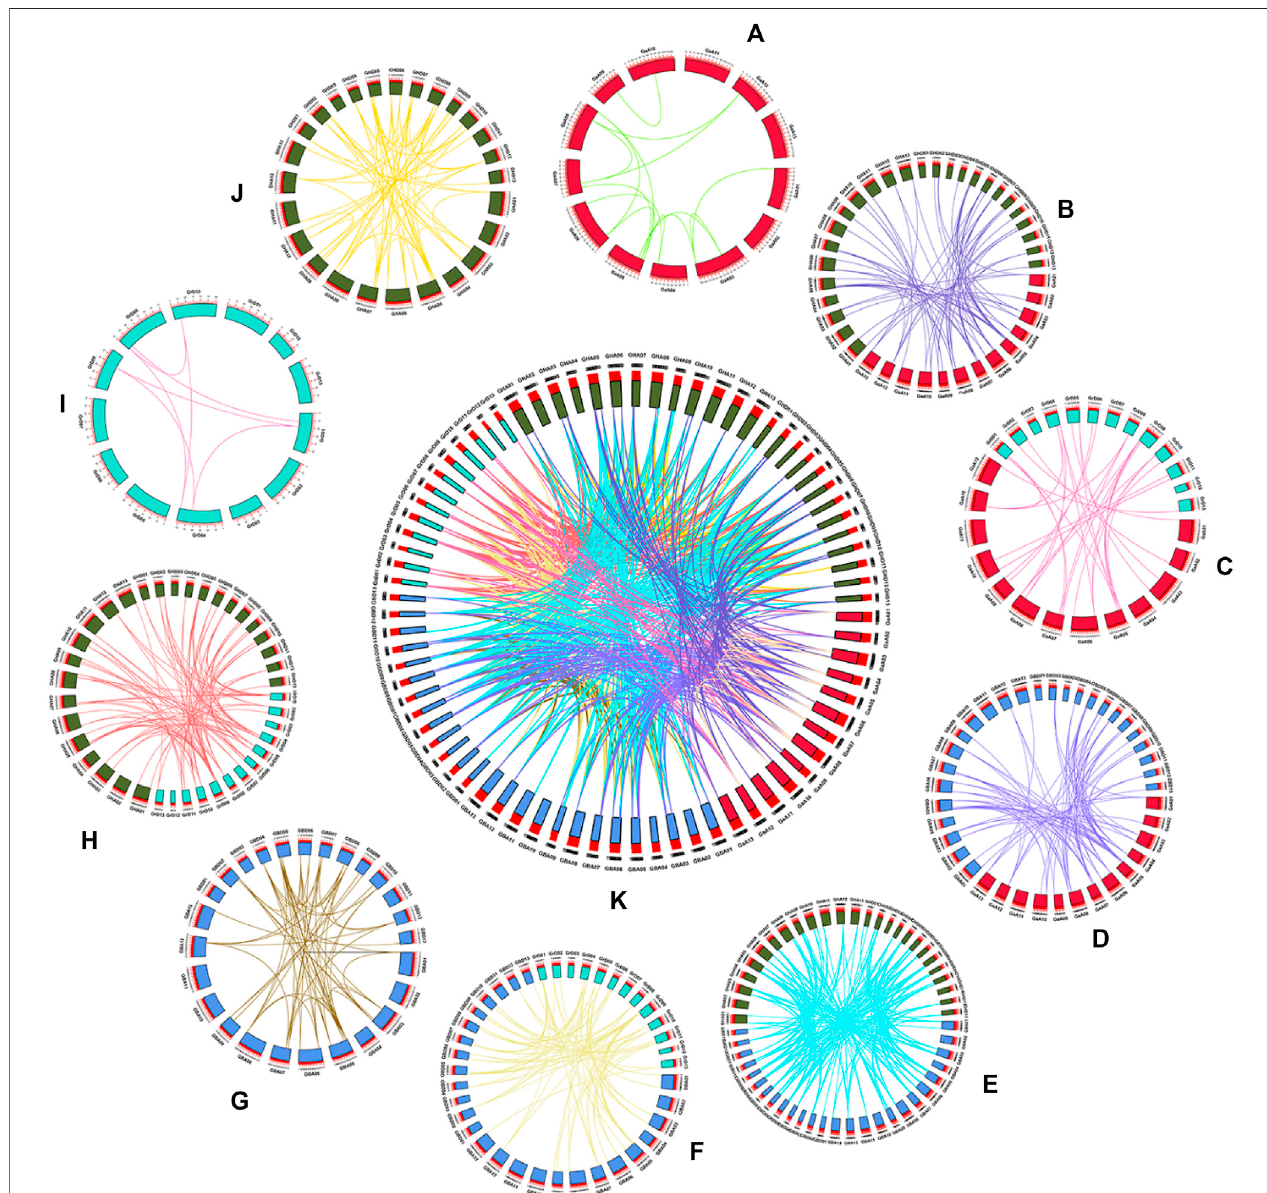
FIGURE 6 | The collinearity of KCS genes within and among the four cotton species genomes ( Gossypium hirsutum , Gossypium barbadense , Gossypium arboreum and Gossypiumraimondii ).Chromosomallinesrepresentedbyvariouscolorsindicatethesyntenicregionsaroundthe KCS genes. (A) Ga-Ga, (B) Ga-GH, (C) Ga-Gr, (D) Ga-GB, (E) GB-GH, (F) GB-Gr, (G) GB-GB, (H) Gr-GH, (I) Gr-Gr, (J) GH-GH, (K) Summary of 10 combinations of collinearity.